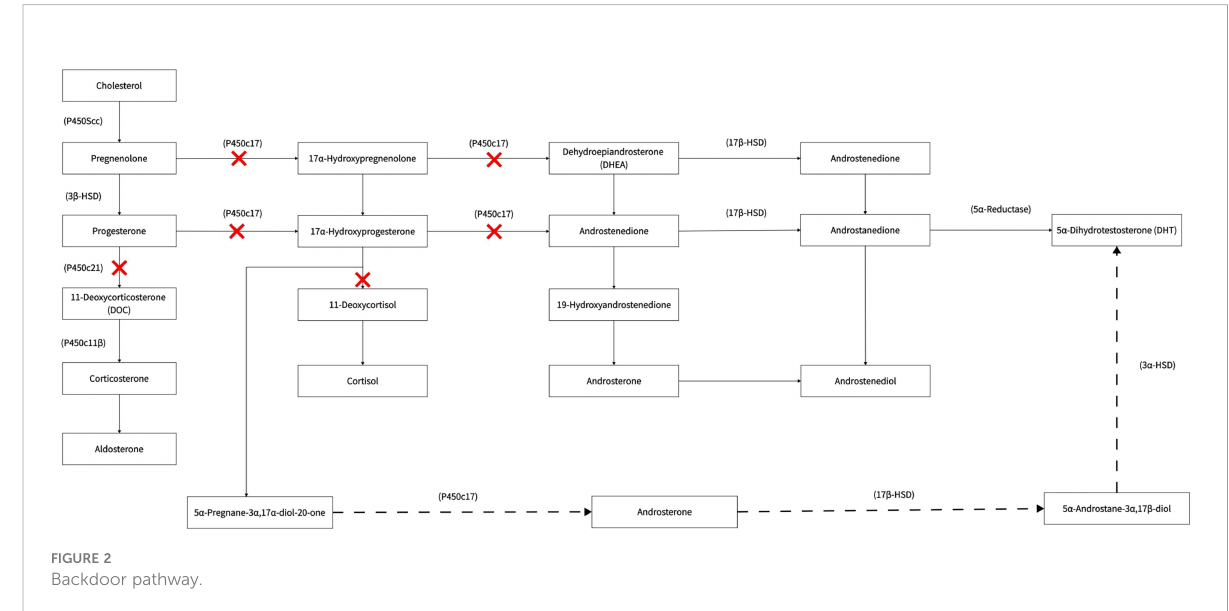
FIGURE 2 Backdoor